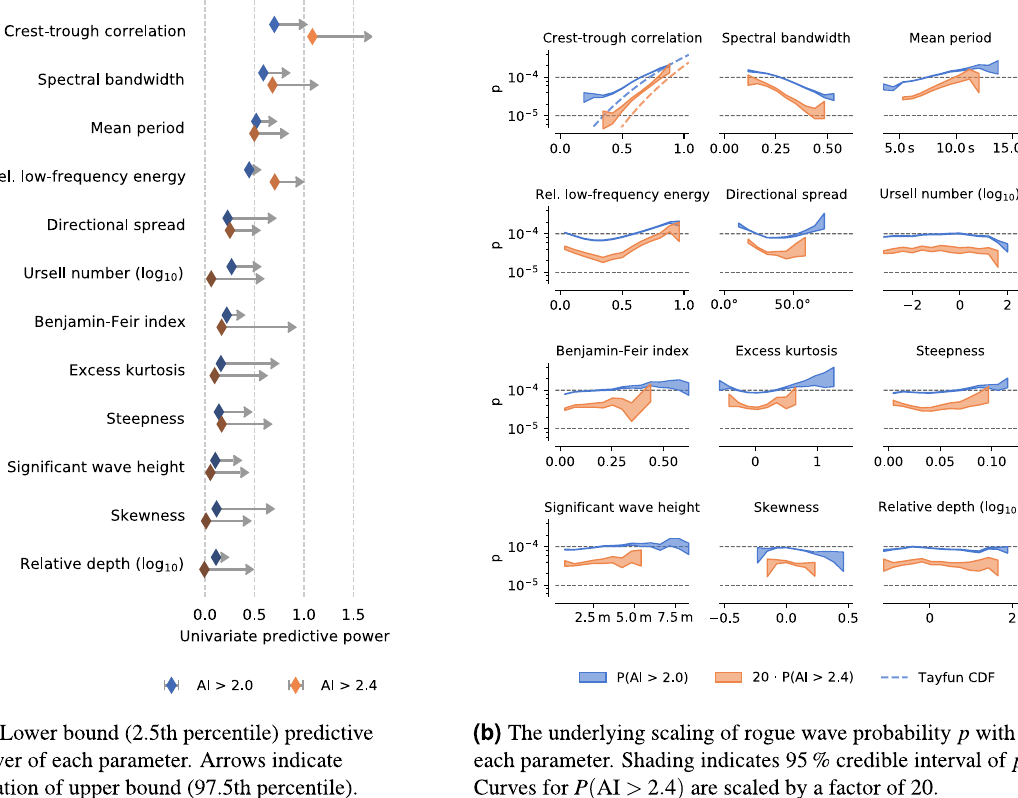
Figure 1. When looking at one sea state parameter at a time, some are better predictors for rogue wave occurrence than others. In particular, crest-trough correlation and spectral bandwidth are much more informative than e.g. Benjamin–Feir index and steepness. ( a ) Shows the predictive power of each parameter, which is computed from the range spanned by the curves in ( b ) (the variation of the rogue wave probability with each parameter).